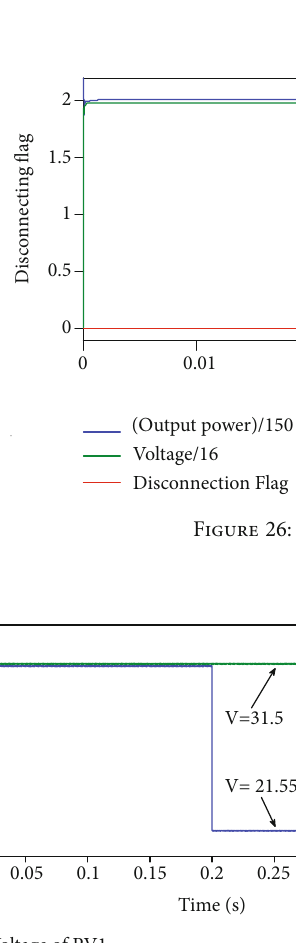
Figure 25: Partial shading condition detection.